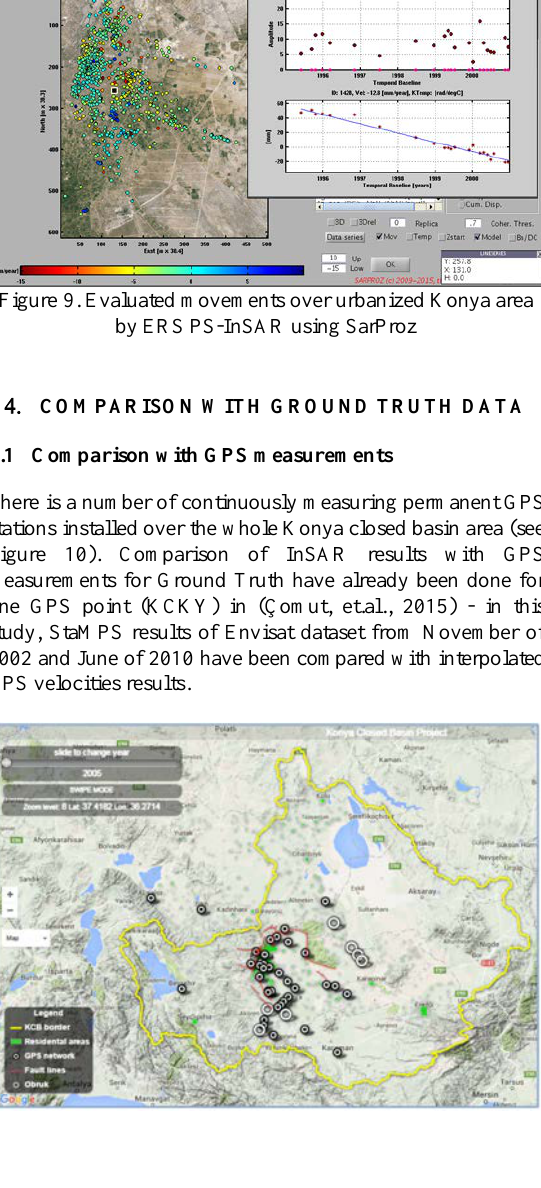
Figure 8. Subsidence as detected from ERS-1/ERS-2 satellites (1995-2000) in Cariklar Fatih and its surroundings (StaMPS). The scale is from -12 (red) to 5 (blue) mm/year